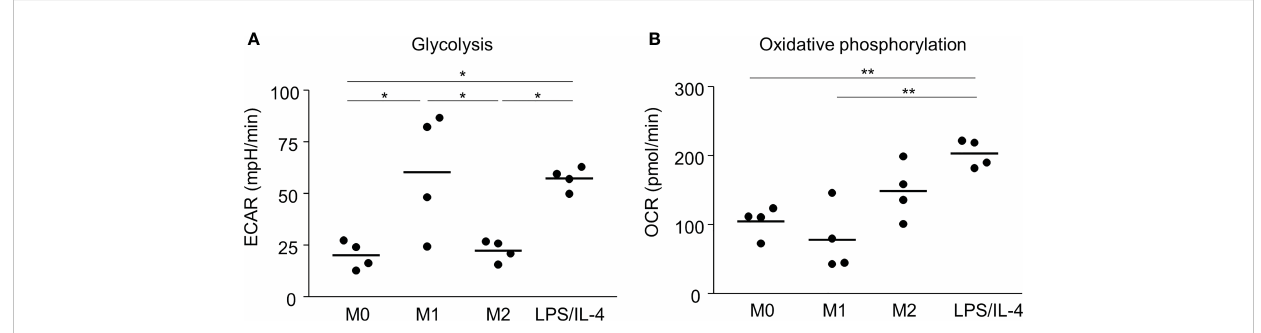
FIGURE 4 LPS/IL-4-induced macrophages activate both glycolysis and oxidative phosphorylation. Bone marrow-derived macrophages were prepared and stimulated with either LPS, IL-4, or LPS plus IL-4. (A) Extracellular acidi fi cation rate (ECAR) and (B) oxygen consumption rate (OCR) were measured by using a fl ux analyzer. Results of glycolysis (A) and oxidative phosphorylation (B) were measured by using an XF Mito Stress Kit. Data are combined from three or four independent experiments. Horizontal bars indicate mean. * P <0.05, ** P